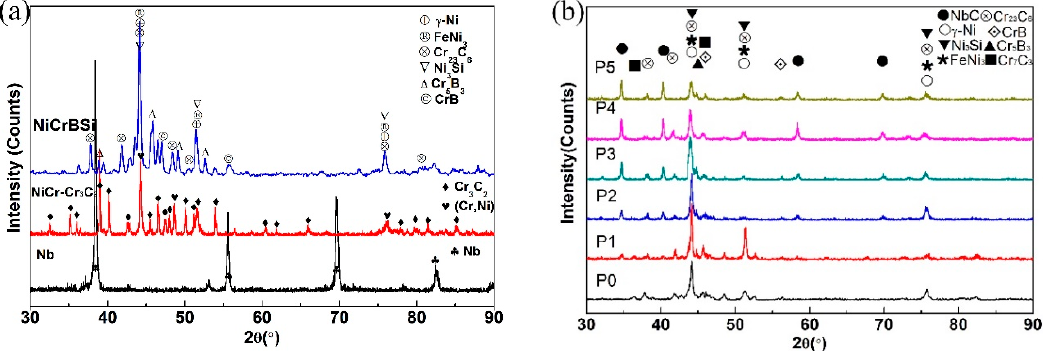
Figure 3. XRD patterns ( a ) powders and ( b ) coatings .